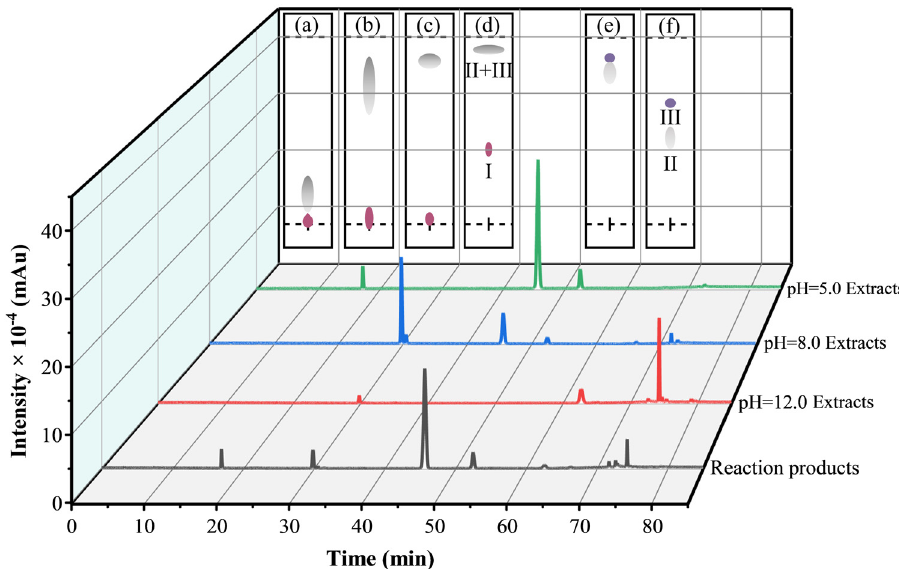
Figure 3: The initial separation of the reaction products was done by extraction after adjusting pH, and the mobile phase of the column chromatography for further separation was screened by TLC: ( a ) CHCl 3 100 vol%; ( b ) CHCl 3 95 vol% + MeOH 5 vol%; ( c ) CHCl 3 95 vol% + MeOH 5 vol% + HCOOH; ( d ) CHCl 3 85 vol% + MeOH 15 vol% + HCOOH; ( e ) CHCl 3 50 vol% + ethyl acetate 50 vol% + HCOOH; and ( f ) n - hexane 50 vol% + CHCl 3 25 vol% + ethyl acetate 25 vol% +